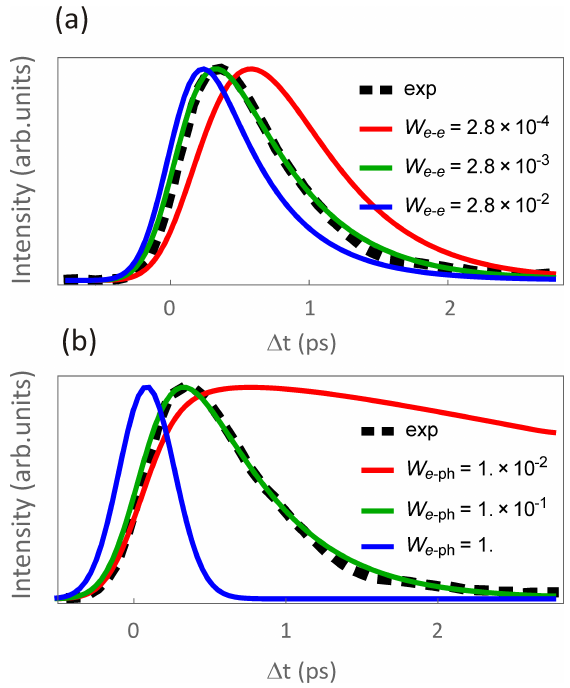
Figure 5. Parameter-sensitive calculation using the GW +Boltzmann approach and its comparison to experiment. ( a ) effect of changing the amplitude of the electron–electron scatterings ( W e-e) while keeping constant the strength of electron–phonon coupling ( W e-ph ). Here, the time evolution of the lowest-energy state within the Dirac cone of Bi 2 Te 3 is taken as an example; ( b ) similar calculations as in ( a ), but changing instead W e-ph while keeping W e-e constant. As indicated in the legends, black-dashed lines are the experimental result and thick solid lines of different colors the corresponding